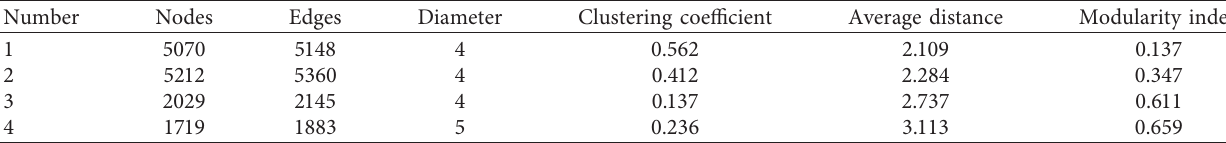
Figure 10: Comment networks of the four popular rumors. (a) Rumor 1. (b) Rumor 2. (c) Rumor 3. (d) Rumor 4. Table 7: Network parameters of the comment